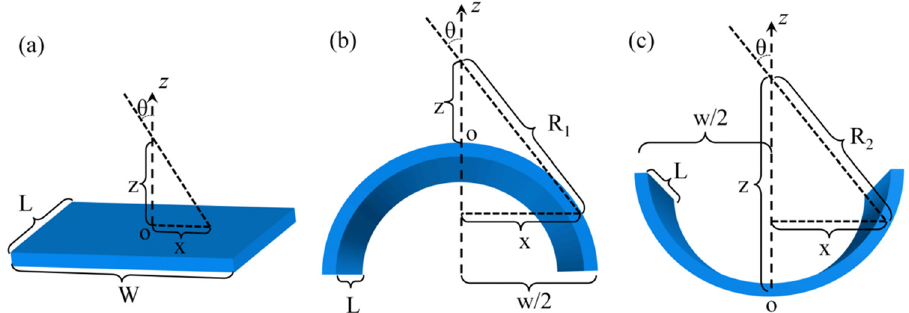
Figure 4: Deriving the DDEF equations for the ( a ) planar, ( b ) convex, and ( c ) concave TENG surfaces [ 49 ]